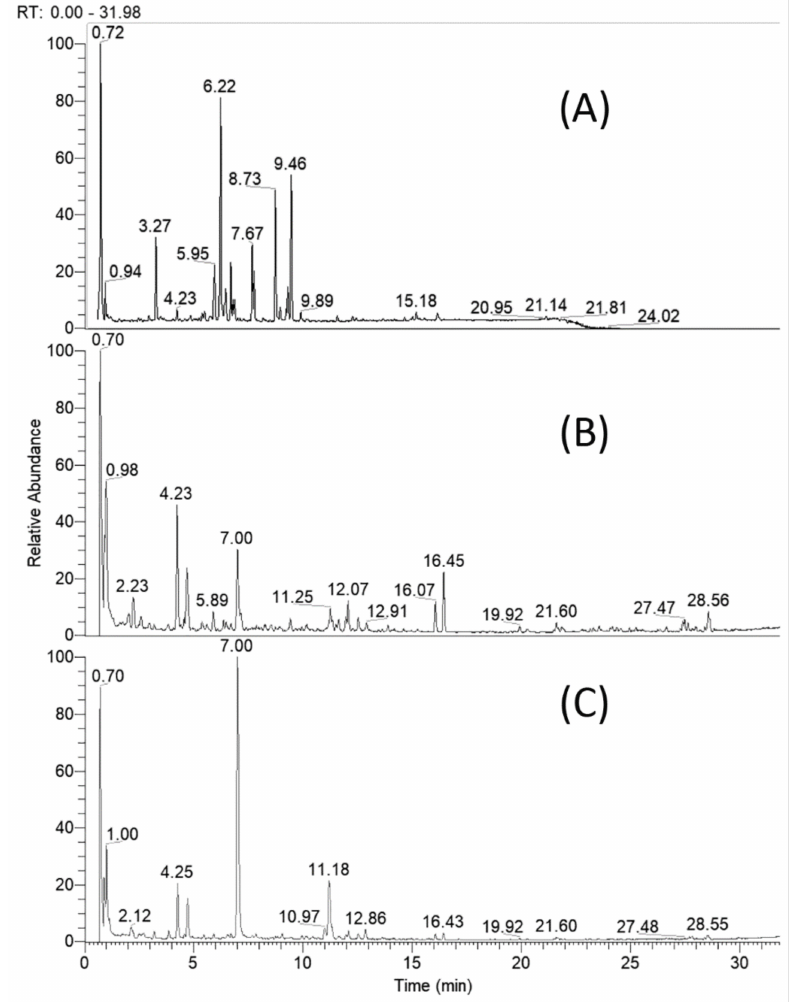
Figure 2. Total ion chromatogram of Cirsium appendiculatum extracts; ( A ) flower heads, ( B ) aerial parts, ( C )